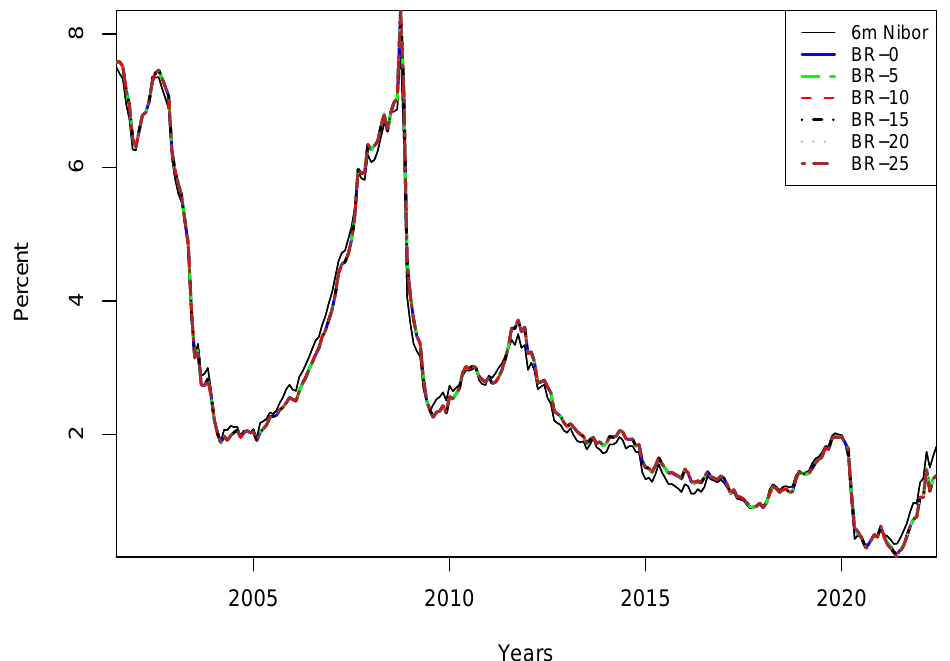
Figure 7. Sensitivity of shadow rates to lower bound. Shadow short rates implied by the BR and the 6 m NIBOR rate. Each panel shows estimated shadow short rates for the lower bound r min varying from 0 to 25 basis points. Sample period: 2001/04 to